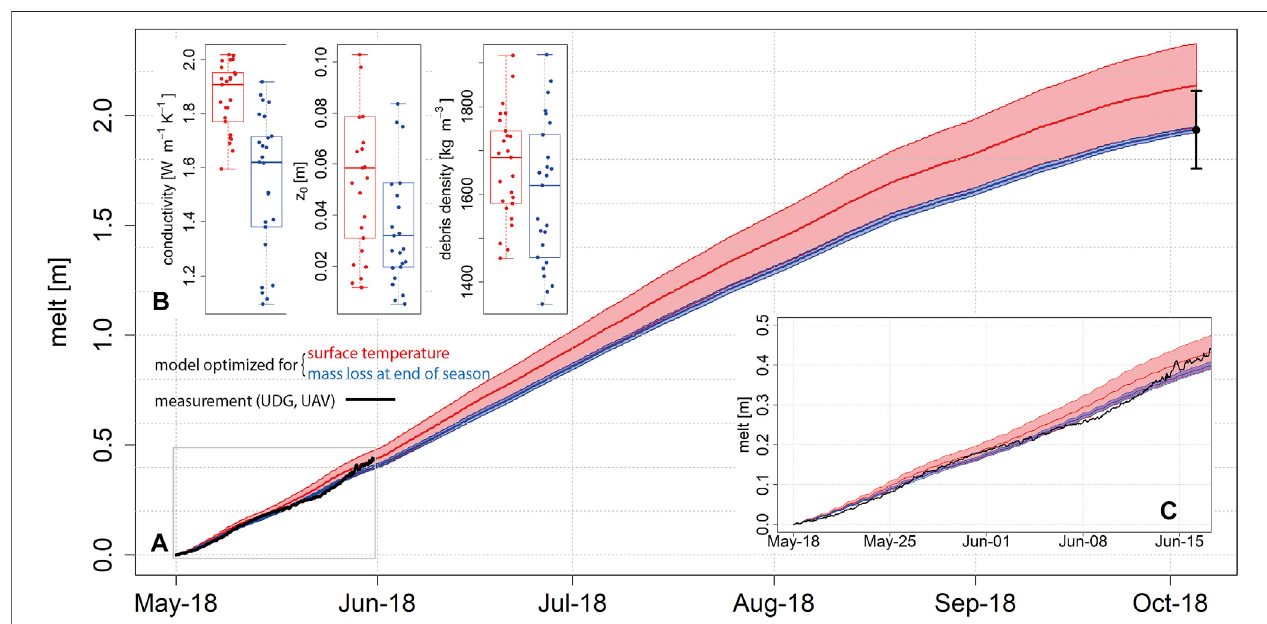
FIGURE 7 | (A) Modeled melt at the location of the AWS in 2013. The blue and red line and shaded area show the mean and standard deviation of the 25 best performing model runs (97.5th percentile) compared to the observed mass loss from the UAV and the observed surface temperature respectively. The error bar of the UAV measurement corresponds to the uncertainty of the DEM accuracy. The solid black line are hourly measurements from an ultrasonic depth gauge (UDG, Table 1 ), which only monitored for a limited time, shown in detail in (C) . (B) Conductivity, surface roughness and debris density for the 25 best performing model runs, once for optimization with UAV (blue) and once with surface temperature